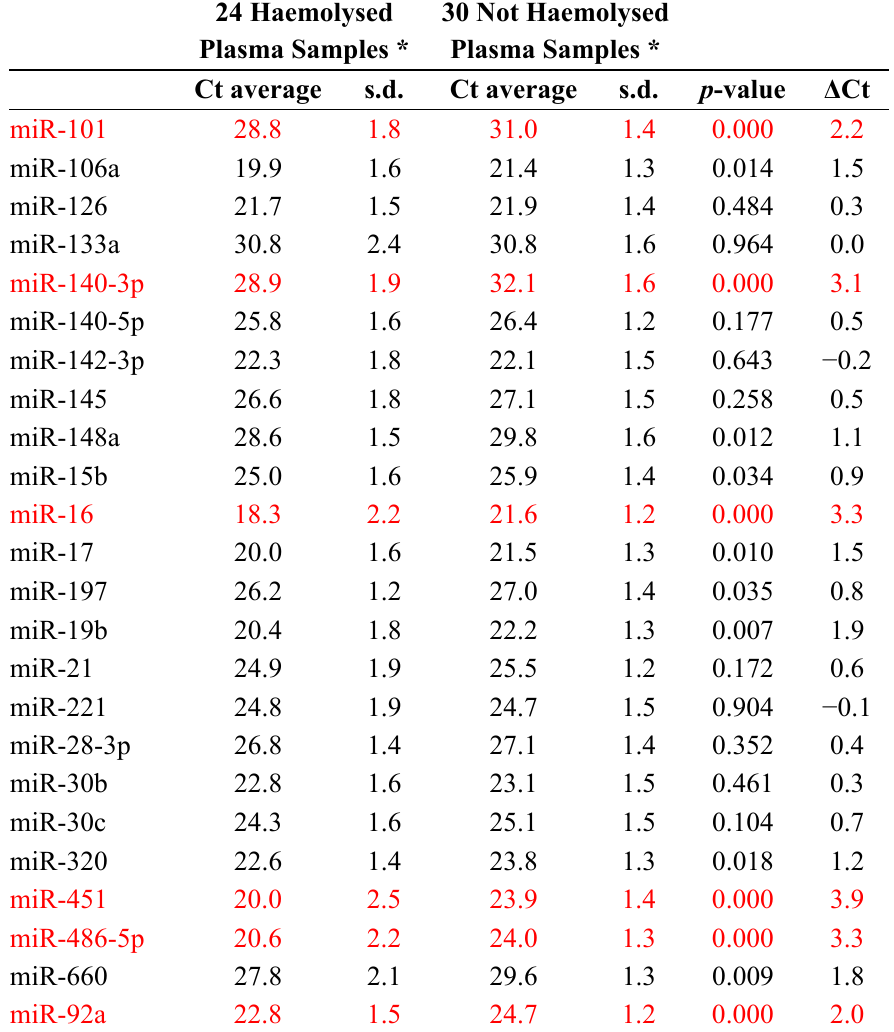
Table 2. Raw Ct values of miRNAs in haemolysed and not haemolysed